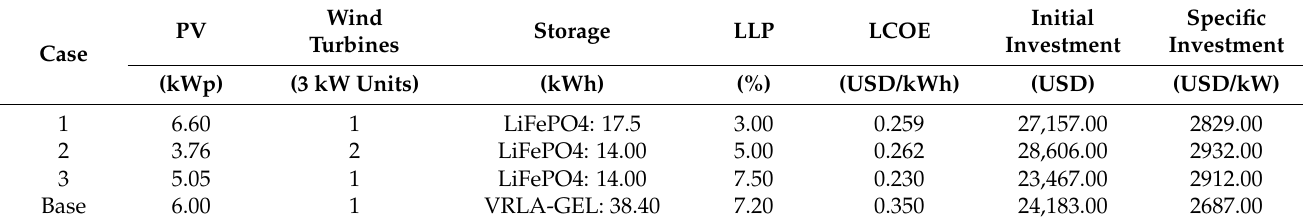
Table 4. HOMER optimized microgrid configurations compared with present case.